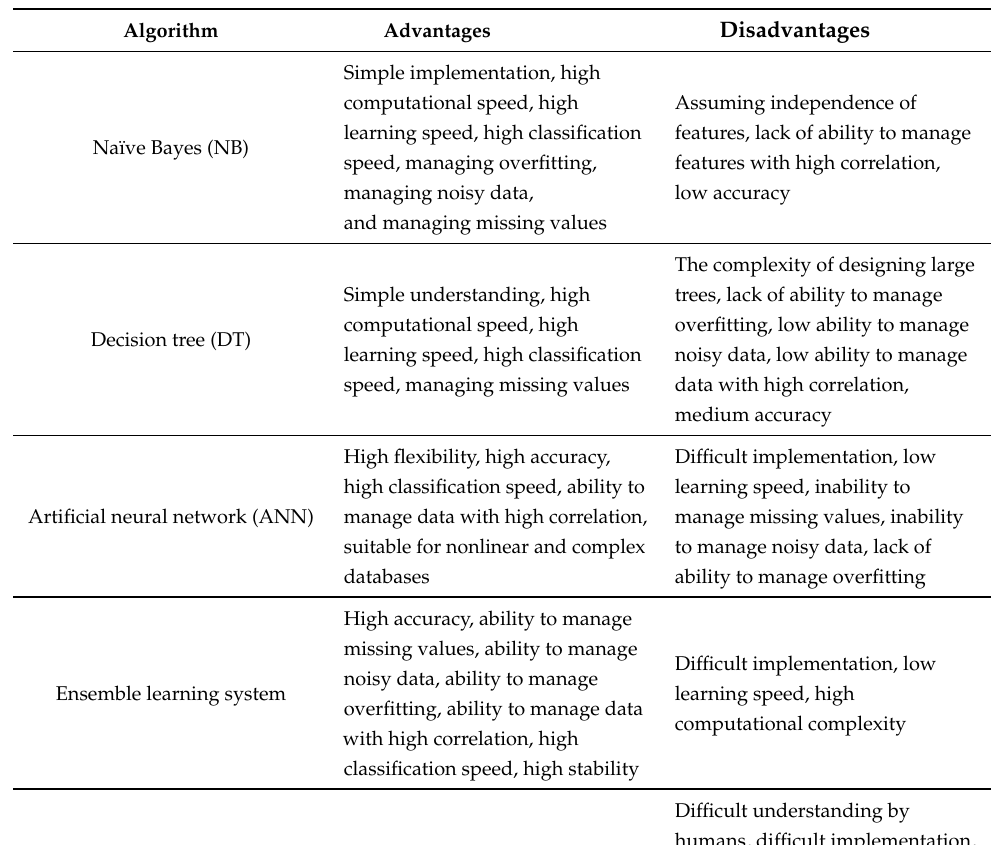
Table 4. Supervised learning methods and their advantages and